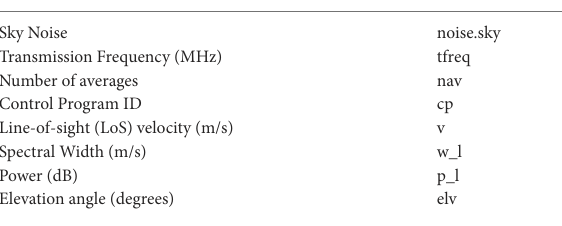
TABLE 1 Commonly used data product and the corresponding string name in SuperDARN DMap